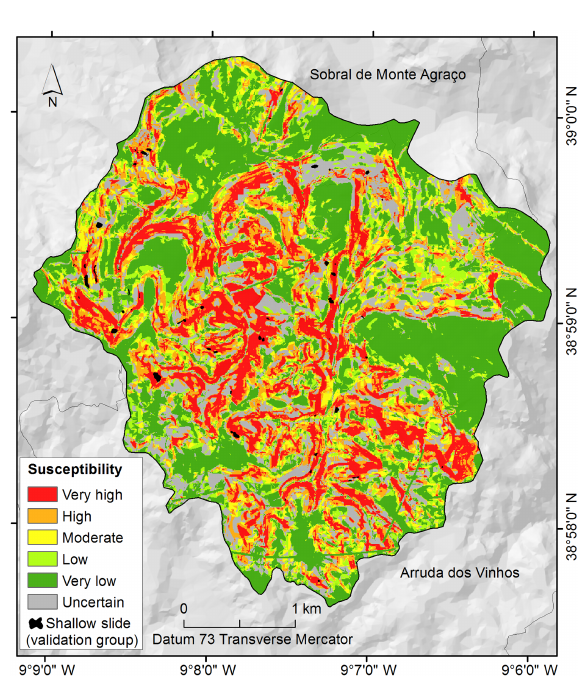
Figure 11. Final shallow slide susceptibility map resulting from the combination of IV and IS susceptibility